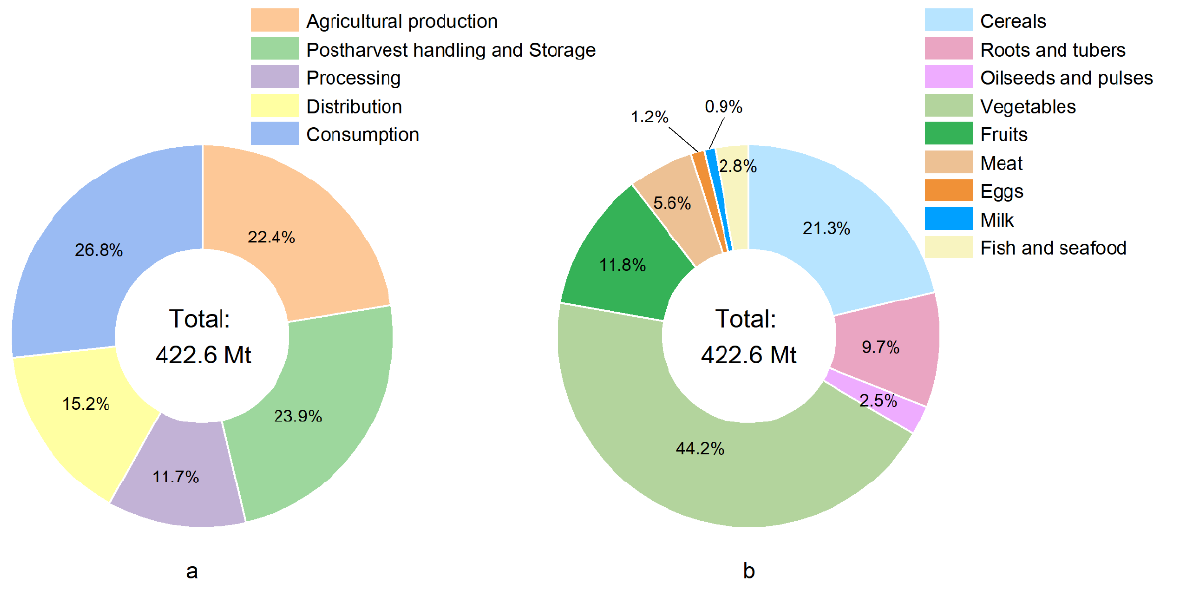
Figure 4. FLW amount share by FSC stages ( a ), and FLW amount share by food categories ( b